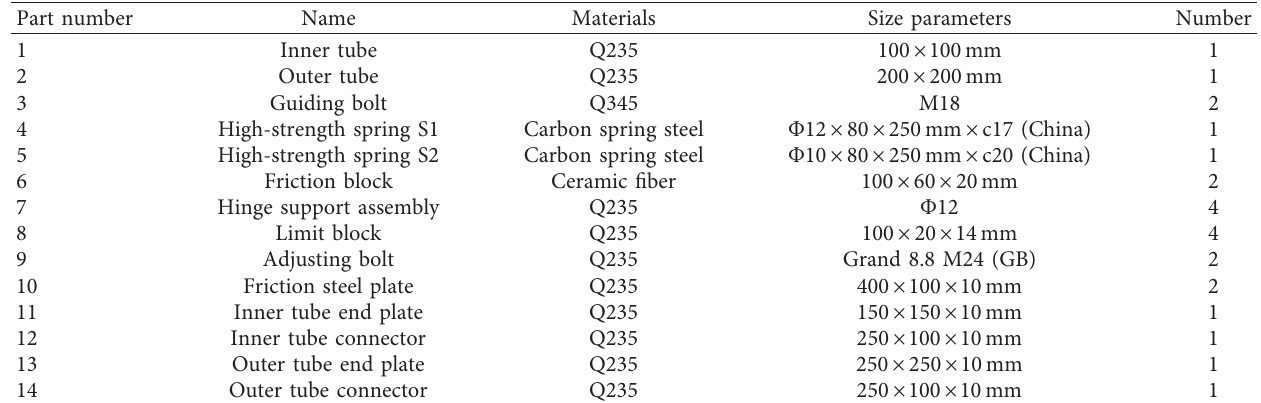
Figure 1: Design dimensions of the main parts and SCVF brace specimen. (a) The overall structure of the proposed SCVF brace. 1: inner tube; 2: outer tube; 3: guiding bolt; 4: tension spring; 5: ceramic friction block; 6: fixed hinge support assembly; 7: limit block; 8: adjusting screw bolt; 9: friction steel plate; 10: inner tube end plate; 11: inner tube connector; 12: outer tube end plate; 13: outer tube connector. (b) Size of the outer tube of the SCVF brace (mm). (c) The size of the inner tube of the SCVF brace (mm). (d) Specimen of the SCVF brace (axial scale Table 1: Specimen design parameters.